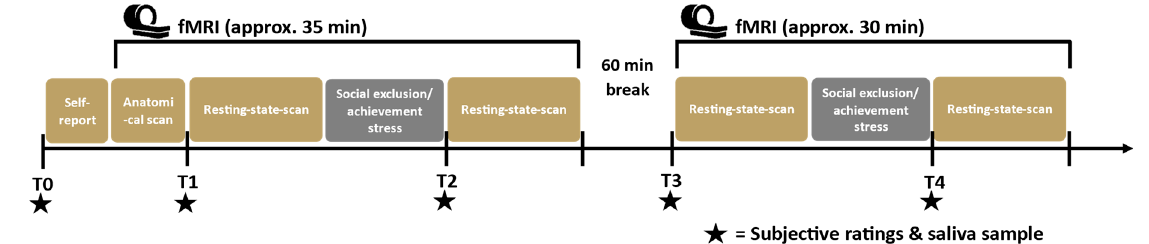
Figure 1. Study design. After arrival and self-report questionnaires, two fMRI sessions consisting of an anatomical scan (only before the first session), two rs scans per session, a stress induction task using either the Cyberball (for social exclusion) or modified MIST (for achievement stress) were administered to participants, with a 60 min break in between. Saliva samples and subjective ratings were collected at dedicated time points. Social exclusion and achievement stress tasks were administered in a randomised order, counterbalanced between females and males.